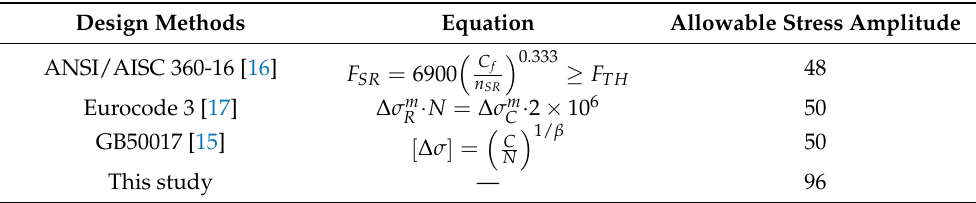
Table 5. Comparison of fatigue strength values obtained with this study and different design codes